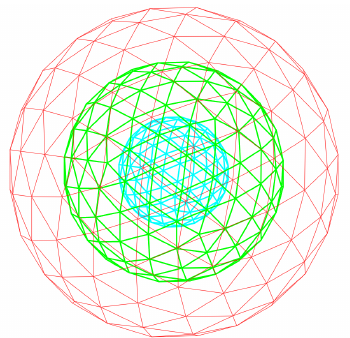
Figure 4. The outer sphere projects points far from the target point, and the points are assigned to red values in a color image. The middle sphere projects points are located midway from the target point, and the points are assigned to green values in a color image. The inner sphere projects points close to the target point, and the points are assignment to blue values in a color